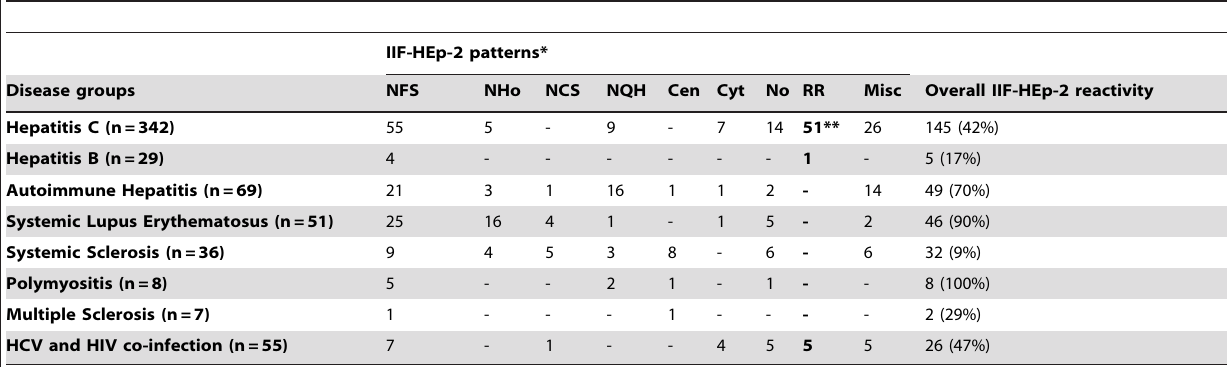
Table 1. Distribution of patients with HCV and other hepatic and non-hepatic diseases according to the presence of anti-RR and other IIF-HEp-2